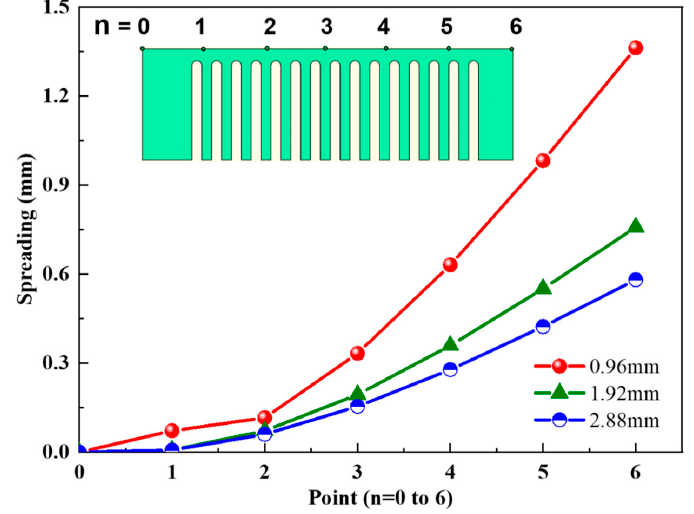
Figure 6. Spreading of the cantilevers depending on bar thickness and measurement point (n). Materials 2018 , 11 , x FOR PEER REVIEW